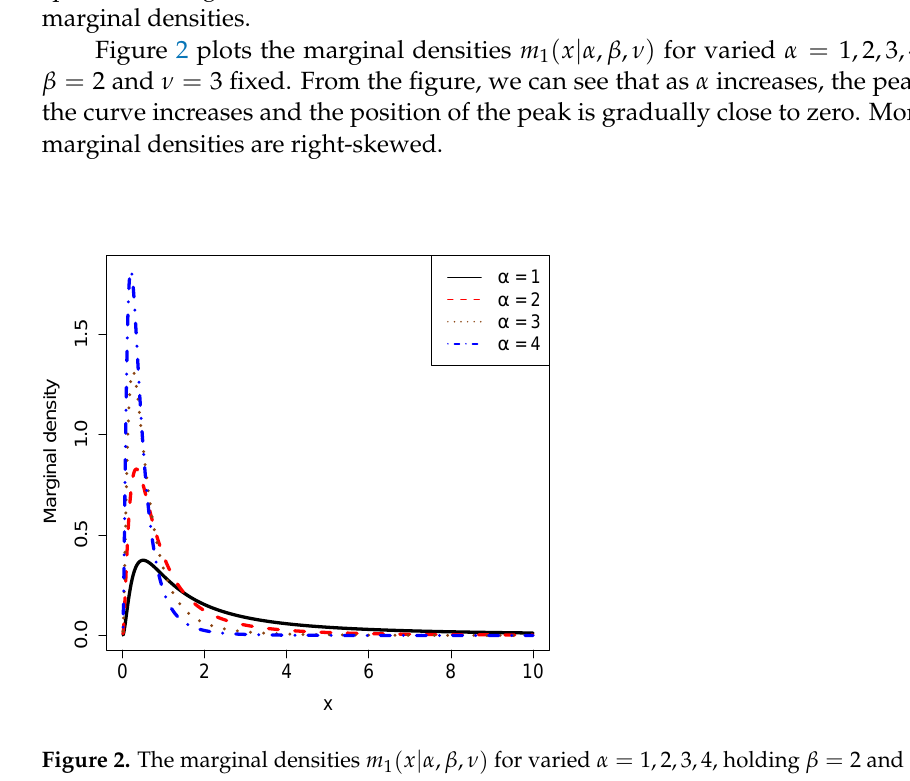
Figure 2. The marginal densities m 1 ( x | α , β , ν ) for varied α = 1,2,3,4, holding β = 2 and ν = 3